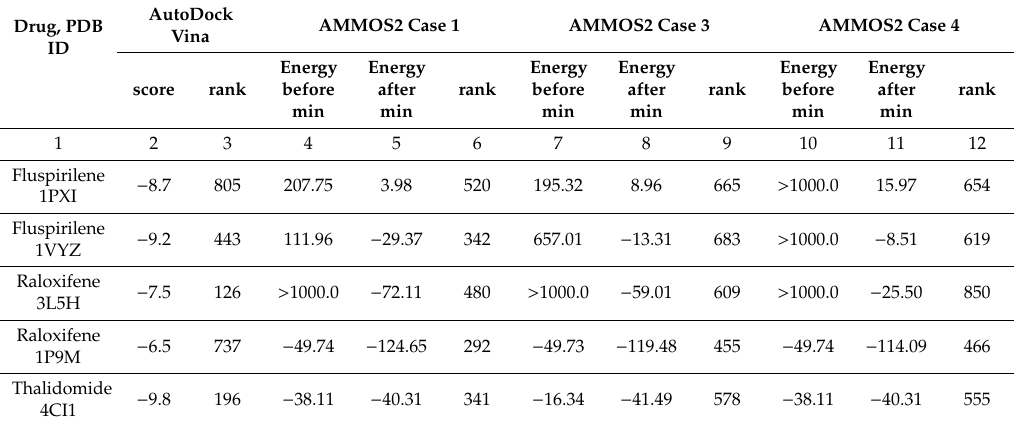
Table 1. MTiOpenScreen and AMMOS2 screening for three proteins.